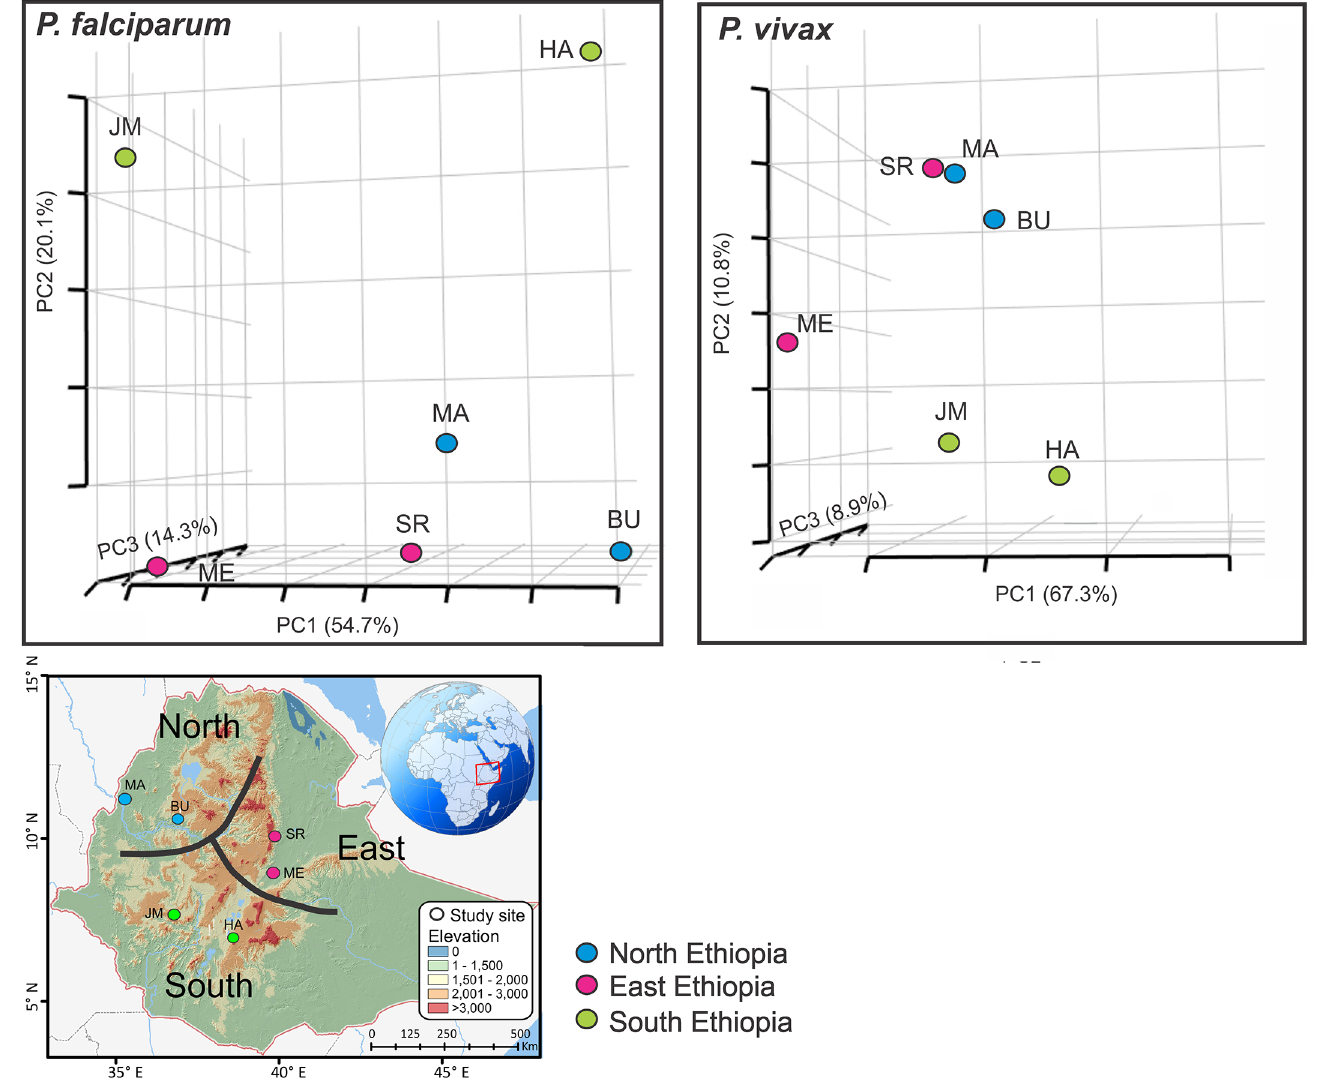
Fig 1. Three dimensional scatterplots of pairwise D S values (an analog of F ST ) showing the genetic relatedness of Plasmodium falciparum and P . vivax among sites. The first three axes that contain nearly 90% of the total variation are shown. Locationsof the studiedsites from different parts of Ethiopiaare presented in the map belowas well as S1